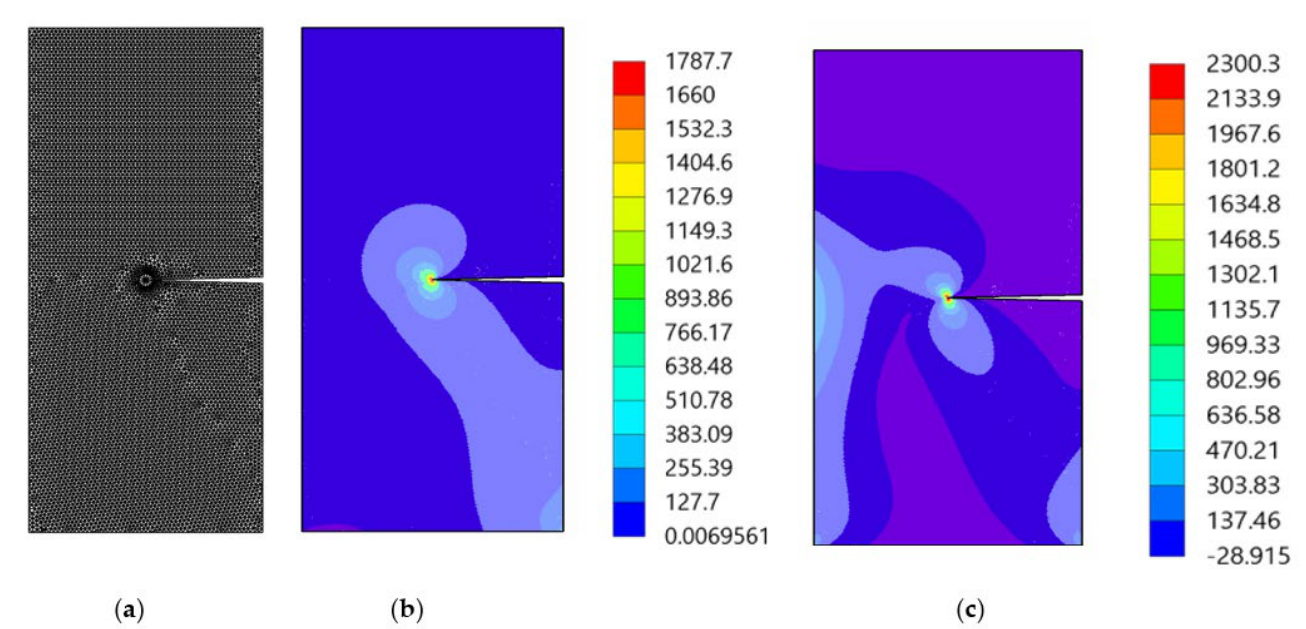
Figure 7. Problem statement for the single edge notched specimen under shear load.